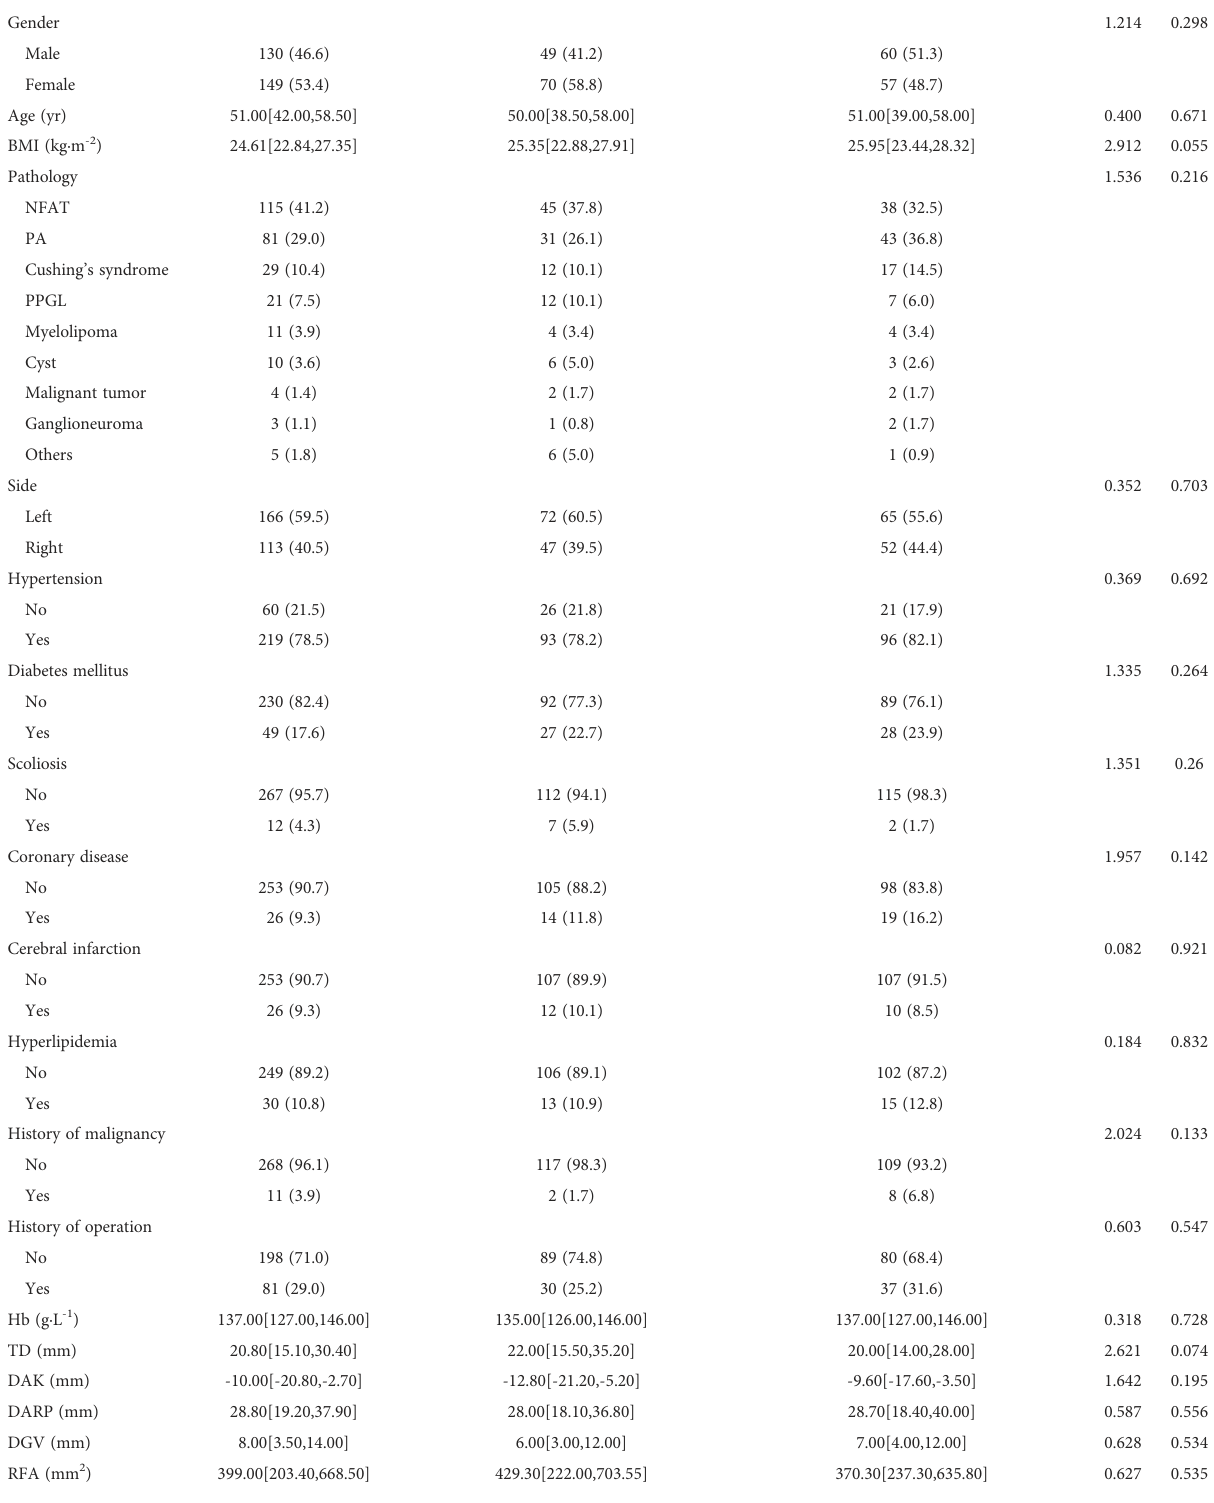
TABLE 1 Baseline characteristics of the